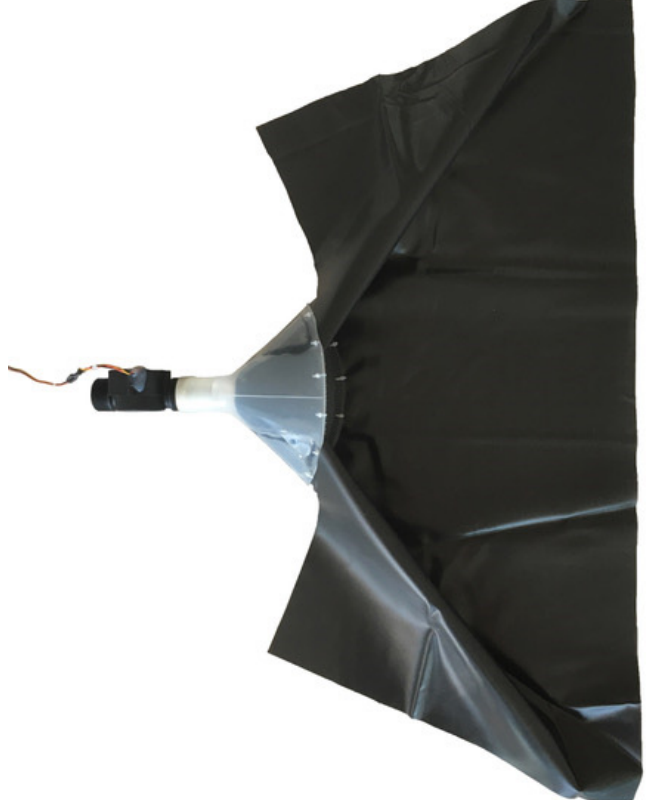
Figure 8. Top view of the flow sensor with funnel and tarp (2017 field season setup).